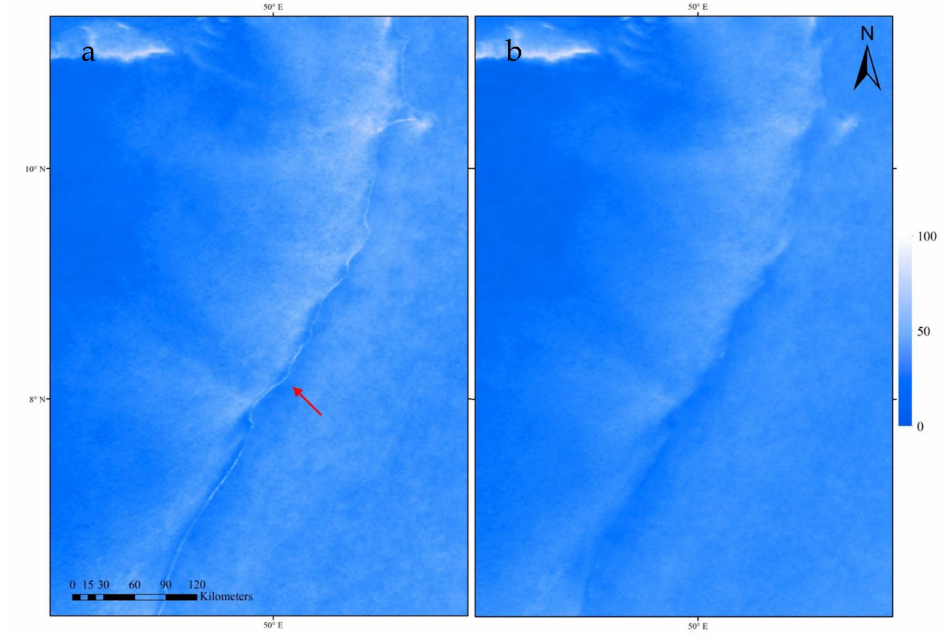
Figure 17. Comparison of the east coast of Africa before ( a ) and after ( b ) removal of the anomaly in the GLHCC01 cloud climatology. The red arrow points to the problem areas with abnormal cloud